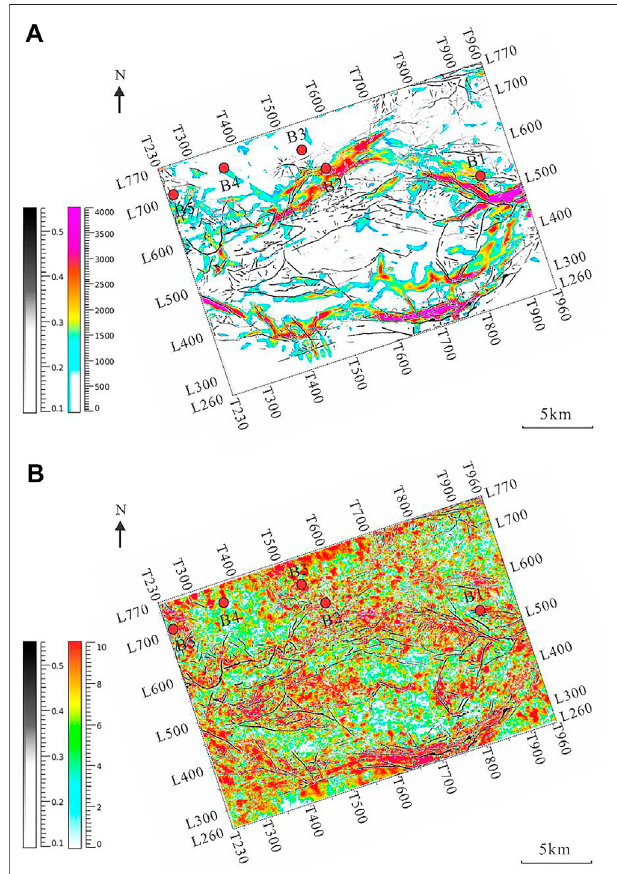
FIGURE 11 | The superposition plane of the upper sweet spot segment before and after stacking. (A) The superimposed plane of the likelihood attribute and curvature attribute. (B) The superimposed plane of pre-stack fracture strength and Likelihood attribute.